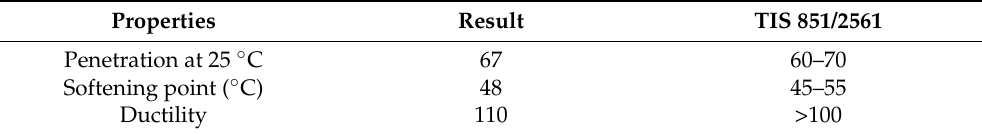
Table 2. Physical properties of